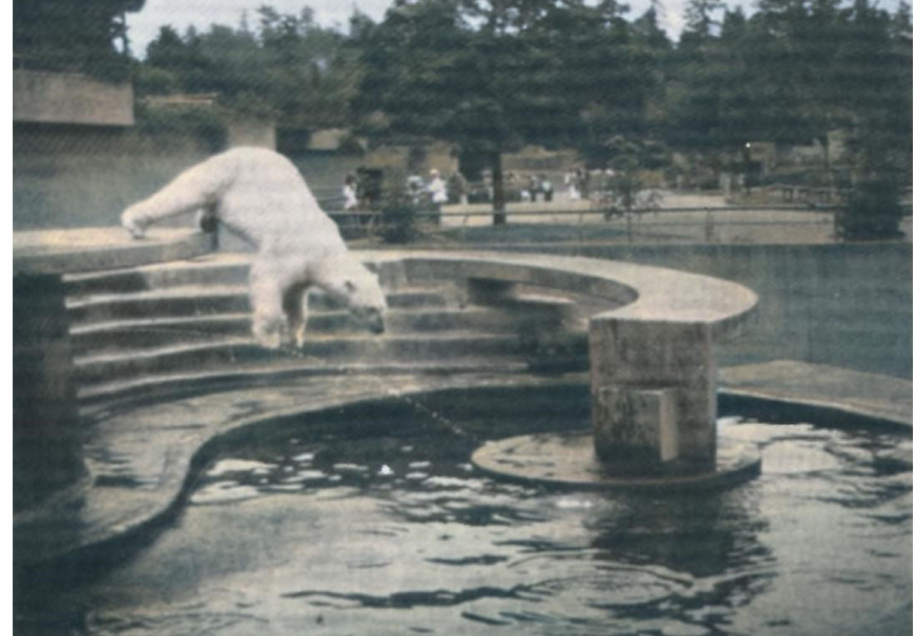
Figure 4. Colorized photo of a polar bear chasing a frozen fish catapulted into their pool at the Portland (Oregon) Zoo, circa mid-1970s. (Reproduced from [63] with permission of American Veterinary Medical Association,